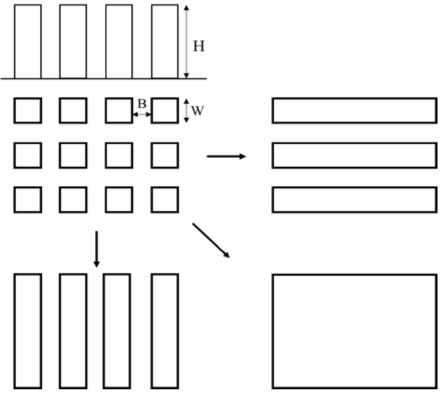
Figure 2. Modeling method of porous media.